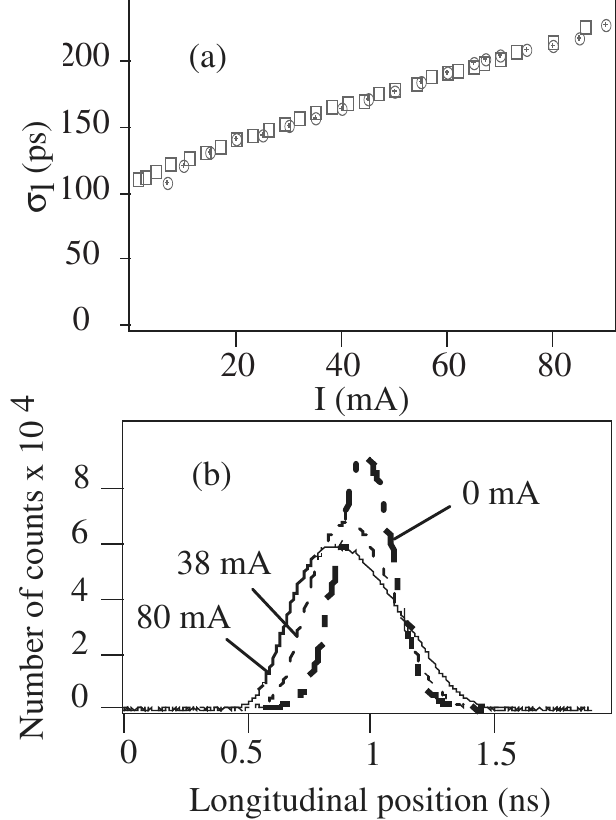
TABLE II. UVSOR-II optical klystron characteristics. (cid:11) the period of the undulator, K the undulator parameter, L dispersive section length, and L